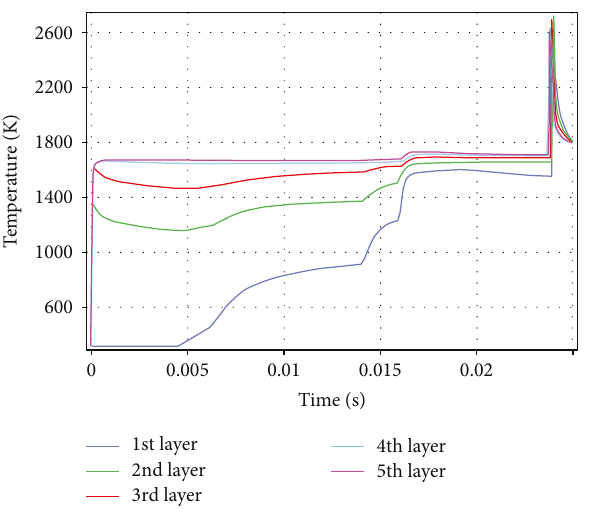
Figure 15: The highest temperature variation curves of the 2nd, 3rd, and 4th layer.